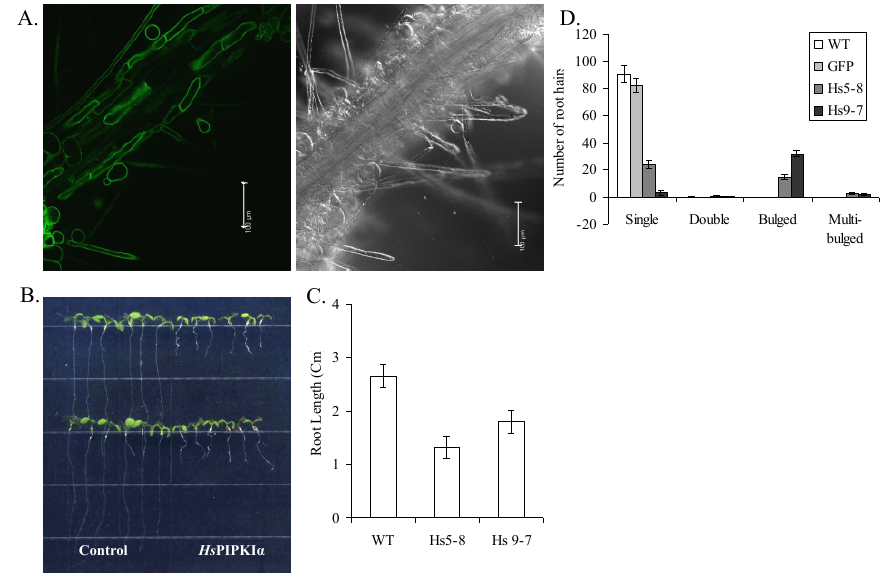
Figure 2. Arabidopsis plants expressing GFP- Hs PIPKIα (Hs5-6, Hs5-8, Hs9-7) have shorter roots than the control plants (WT and GFP expressing plants). ( A ) GFP- Hs PIPKIα localized with the plasma membrane in the root. Transgenic Hs PIPKIα seedlings were imaged using a confocal microscope. Left panel shows fluorescence and right panel shows the differential interference contrast image. Bars = 100 μm; ( B ) 10-d-old Hs PIPKIα seedlings grown on MS media have significantly shorter roots; ( C ). Plates were photographed and root growth was measured using Adobe Photoshop and analyzed using Microsoft Excel. The data are the mean of at least 10 seedling measurements per line ± SD. ( D ) The number of single, double, bulged and multibulged root hairs in 7-d-old wild-type and Hs PIPKIα seedlings were determined. The data are means of 24 seedlings per line ±